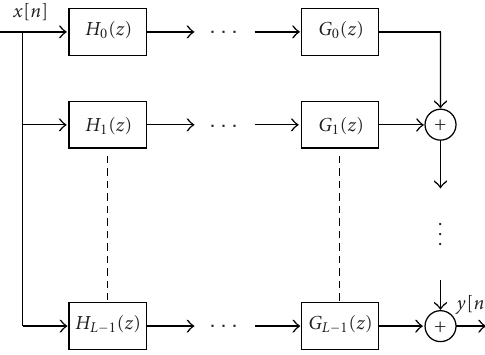
Figure 3: Analysis and synthesis